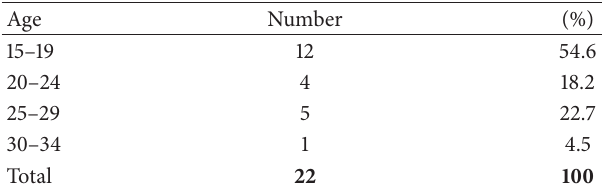
Table 1: Age distribution of the patients.